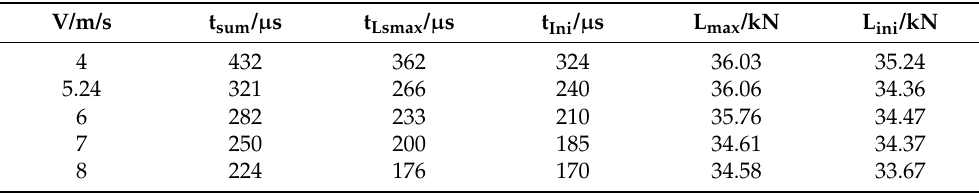
Table 5. Characteristic time and load at different hammer Figure 16. Influence of striker velocity on load–time and energy–time curves.